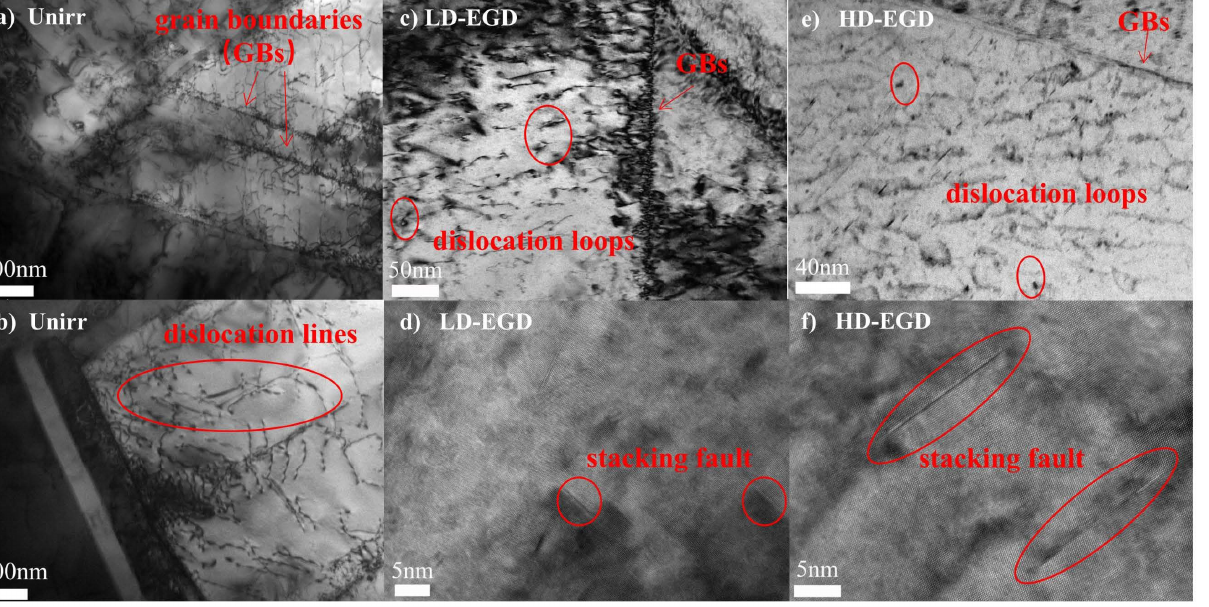
Figure 3. TEM characterization of different samples: ( a ) and ( b ) unirradiated sample, ( c ) and ( d ) low dose with energy gradient degrader (LD-EGD), ( e ) and ( f ) high dose with energy gradient degrader (HD-EGD).